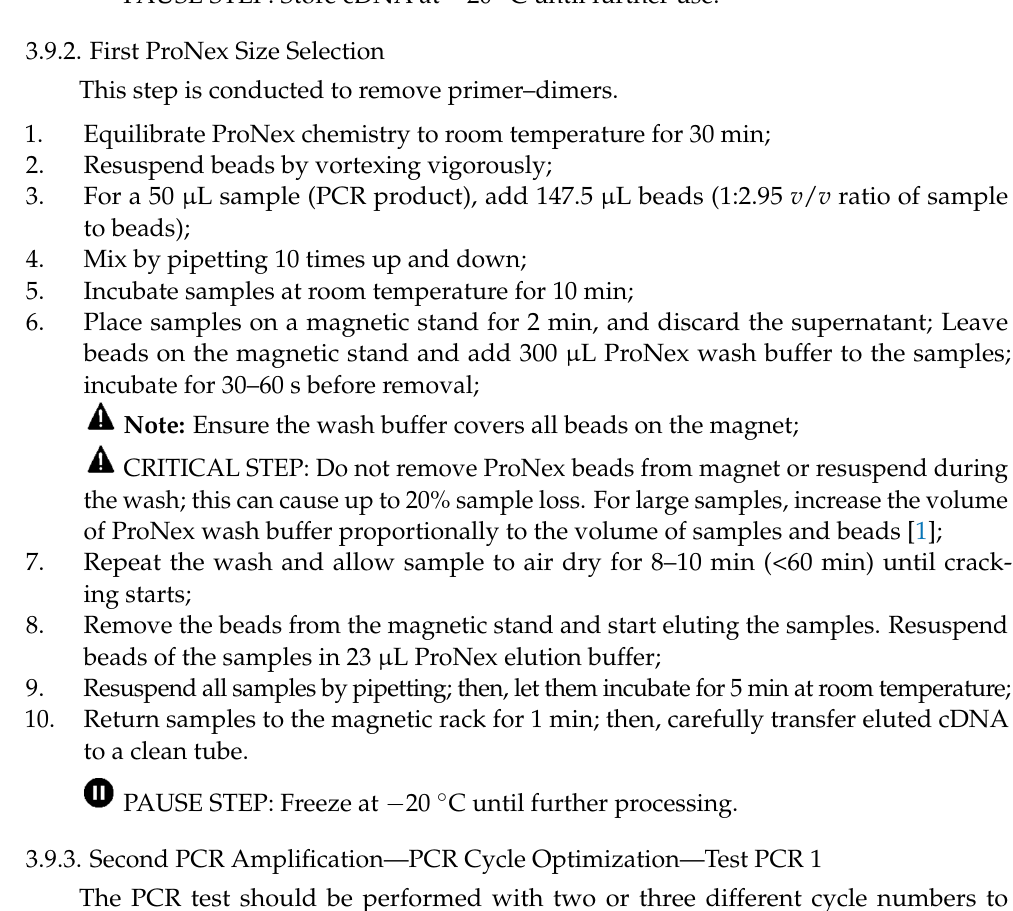
Table 7. RNA-Primer Mix for Reverse